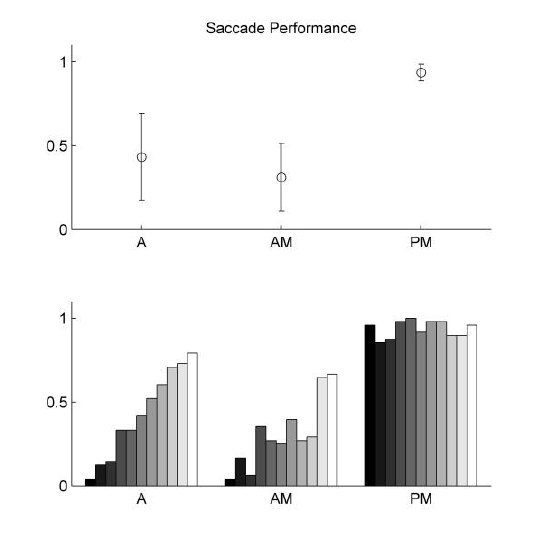
Figure 2. The anti-saccade task (A and AM) is more diffi- cult than the pro-saccade task (PM). The anti-saccade with a concurrent working memory task (AM) is also significantly more difficult than the anti-saccade task alone (A). The average across subjects is shown at the top, and individual subject data is shown at the bottom. Individual subject is coded by the same